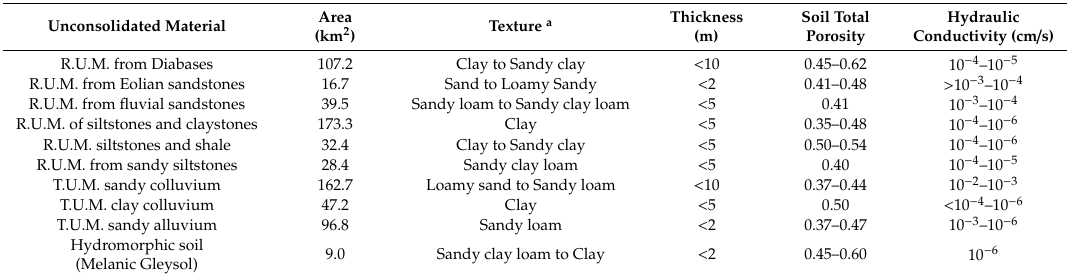
Table 3. Basic geotechnical characteristics of the unconsolidated materials in the study region. Unconsolidated